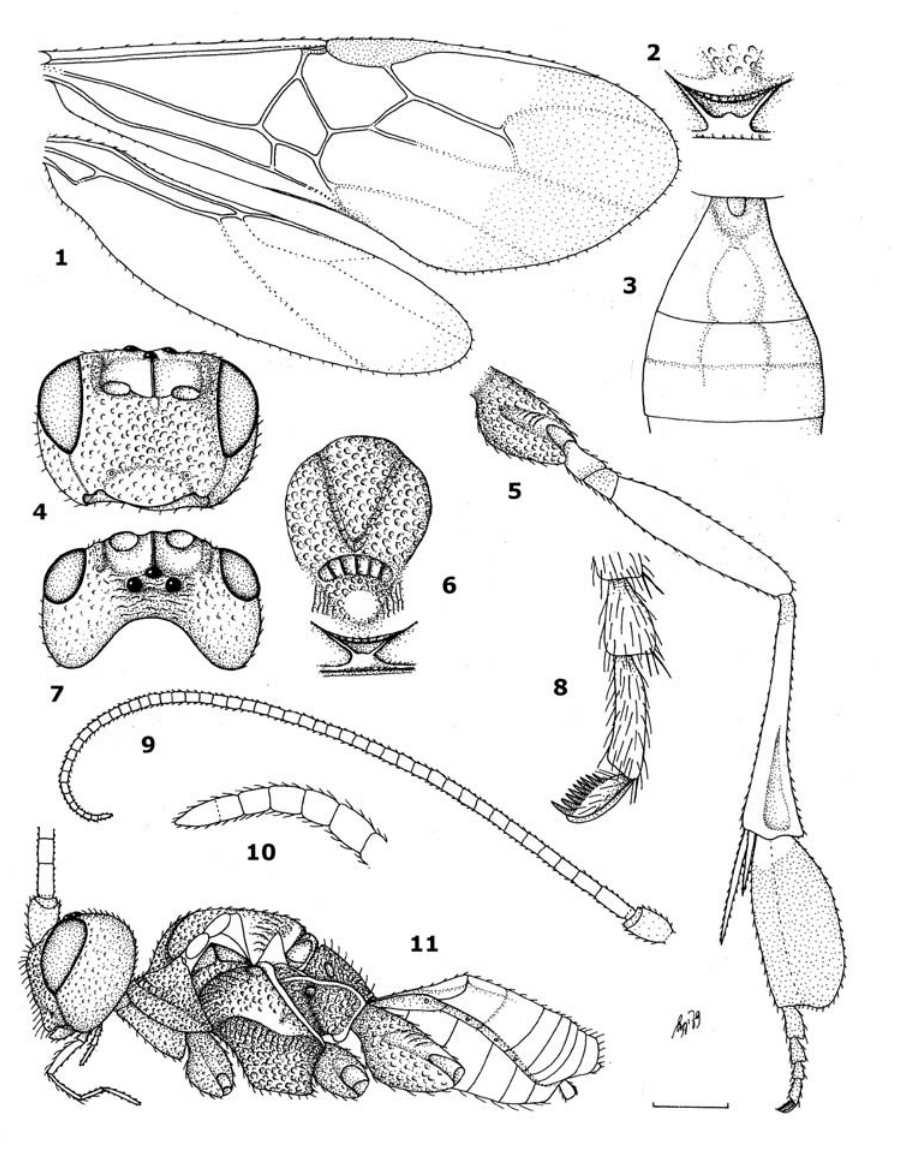
Figures 1–11. Hartemita muirii (Fullaway), female, holotype. 1 wings 2 metanotum dorsal 3 first-third metasomal tergites dorsal 4 head frontal 5 hind leg 6 mesosoma dorsal 7 head dorsal 8 outer hind claw 9 an- tenna 10 apex of antenna 11 habitus lateral. 1, 5, 9, 11: 1.0 × scale bar 2: 2.6 × 3, 4, 6, 7: 1.3 × 8, 10: 5.0 ×. Description. Holotype, female, body length 6.2 mm, fore wing length 7.3 mm, antenna 7.8 mm. Head . Antennal segments 52; third segment 1.2 times as long as fourth segment; length of third, fourth and penultimate segments 2.3, 1.9 and 2.0 times their